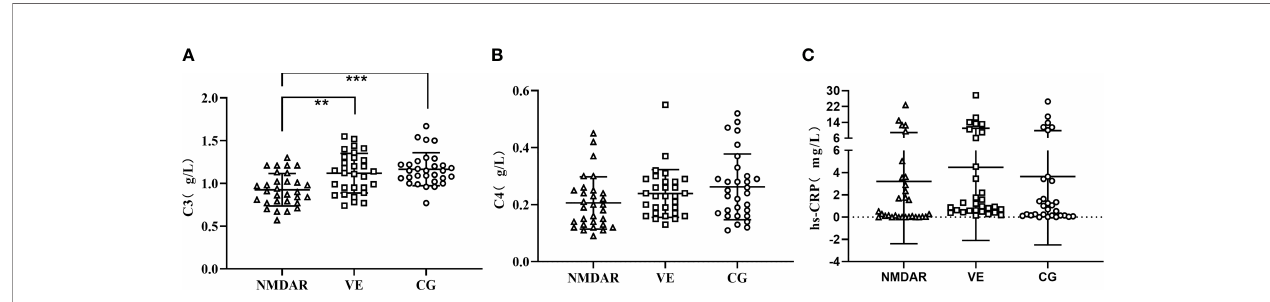
FIGURE 3 | The expression levels of serum C3, C4, and hs-CRP. (A) The expression level of C3 among three groups. (B) The expression level of C4 among three groups. (C) The expression level of hs-CRP among three groups. (*** p < 0.001; ** p < 0.01; NMDAR, anti- N -methyl- D -aspartate receptor encephalitis; VE, viral encephalitis; CG, control group; C3, complement 3; C4, complement 4; hs-CRP, high